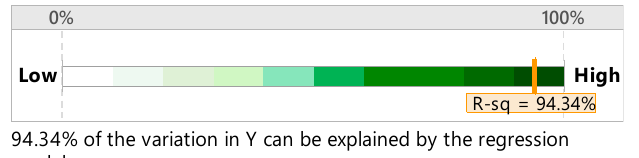
Figure 7. R 2 statistic with % of variation explained by the model.